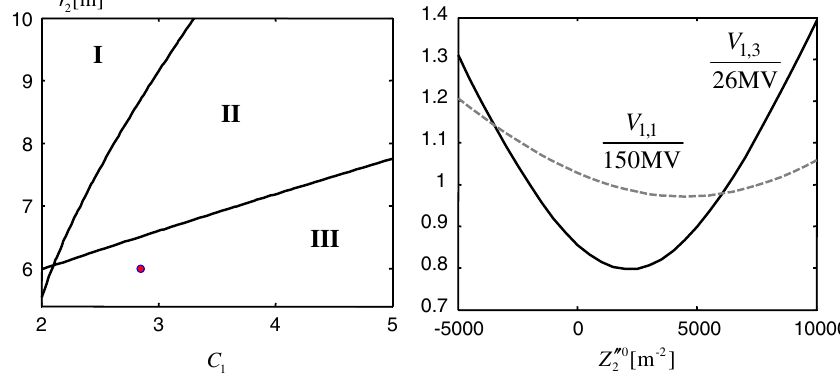
FIG. 6. The left plot shows the level lines for voltages. The circle presents the working point. The right plot shows the required vs parameter Z 00 . voltages in module M 1 2